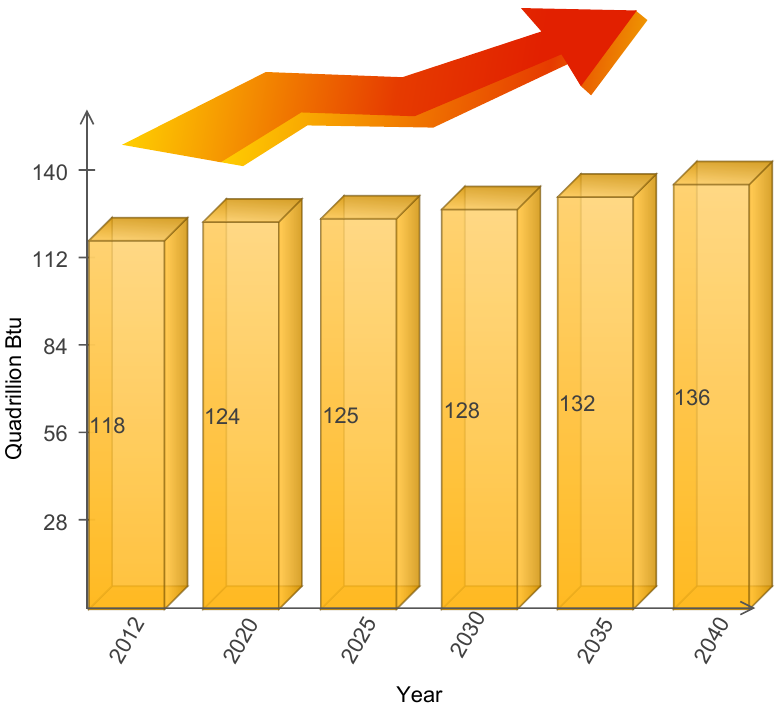
Figure 2. Energy Growth Forecasting Using Deep